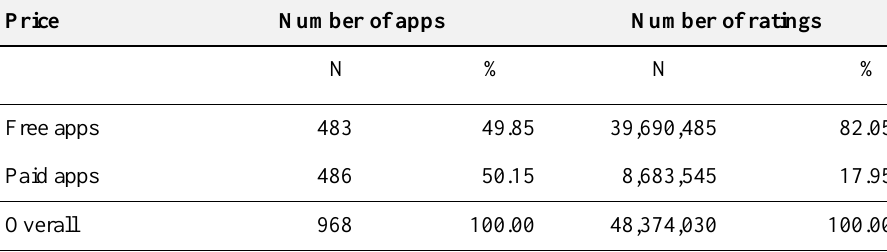
Table 1 – Overview of analysed applications